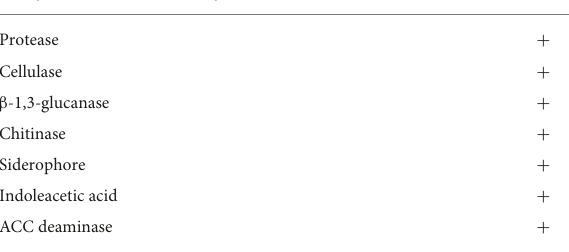
TABLE 3 Detection of antagonistic related products of BR-01.